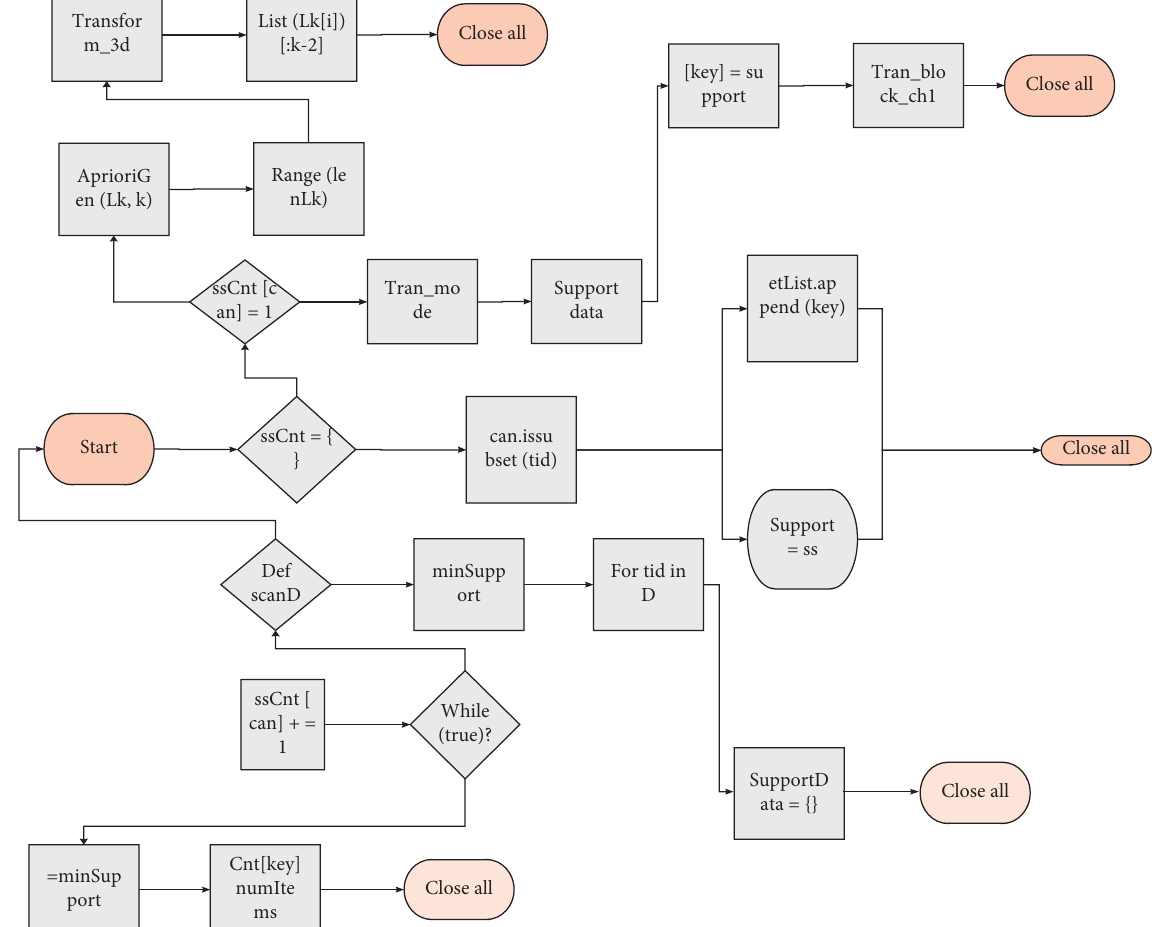
Figure 1: Flowchart of deep learning